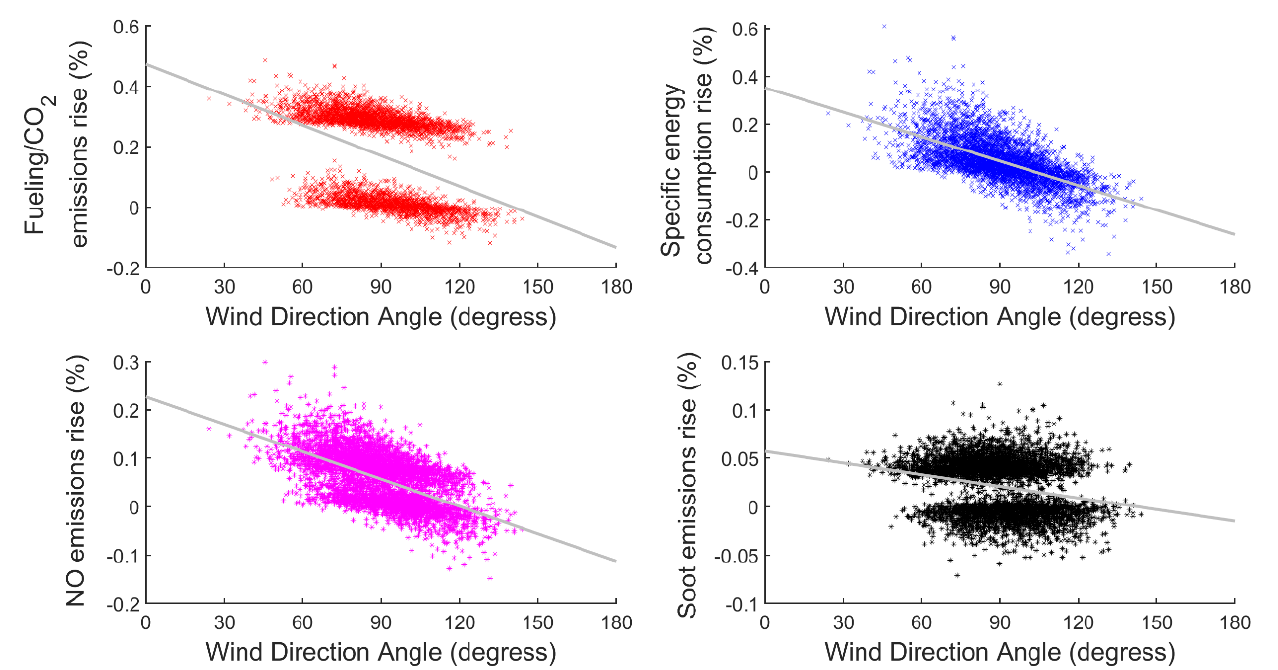
Figure 13. Percentage increase in fuel/energy consumption and emissions vs. mean wind direction for the medium phase of the WLTC.